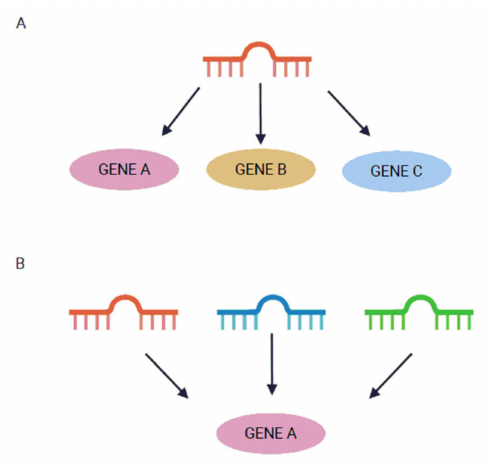
Figure 2. MiRNA binding to target mRNA. A single miRNA can target many mRNAs ( A ). Many miRNAs can target one mRNA ( B